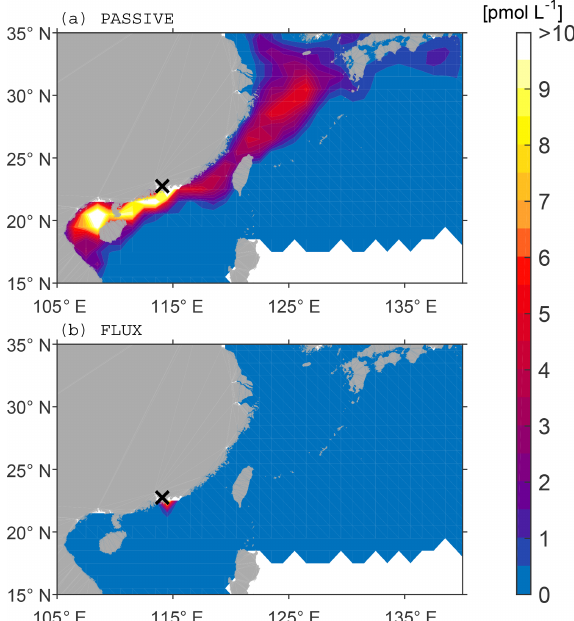
Figure 7. Surface bromoform concentration in the Pearl River Delta for the MODERATE scenario averaged over 1 year. (a) PASSIVE analysis without loss rates. (b) FLUX analysis with outgassing.